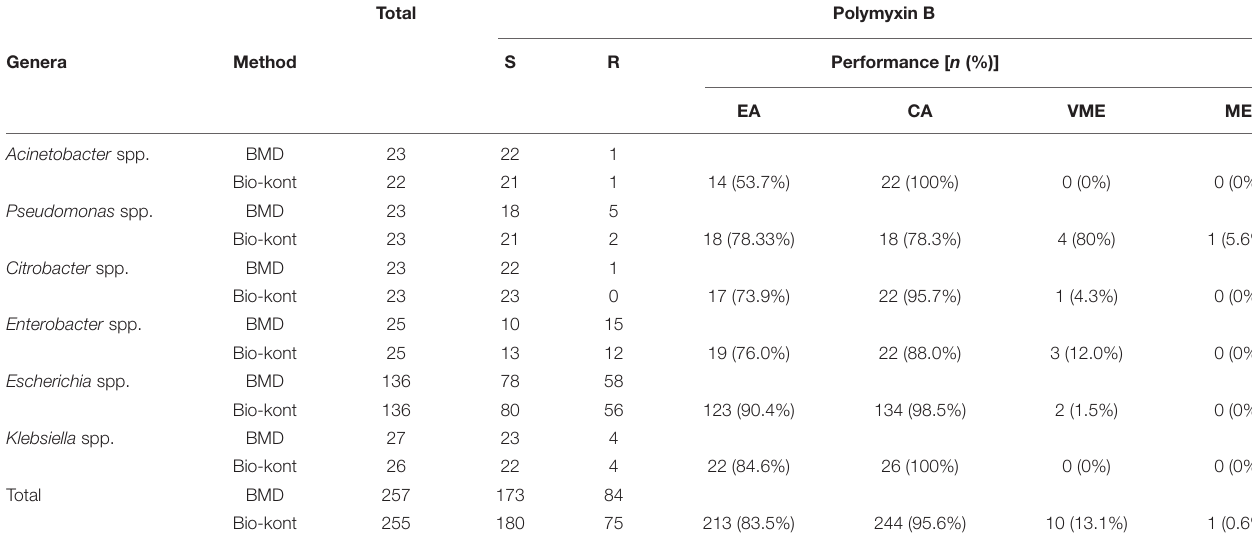
TABLE 1 | Comparison of performance characteristics to polymyxin B between Bio-kont AST System and BMD method for the seven genera in the 257 strains.